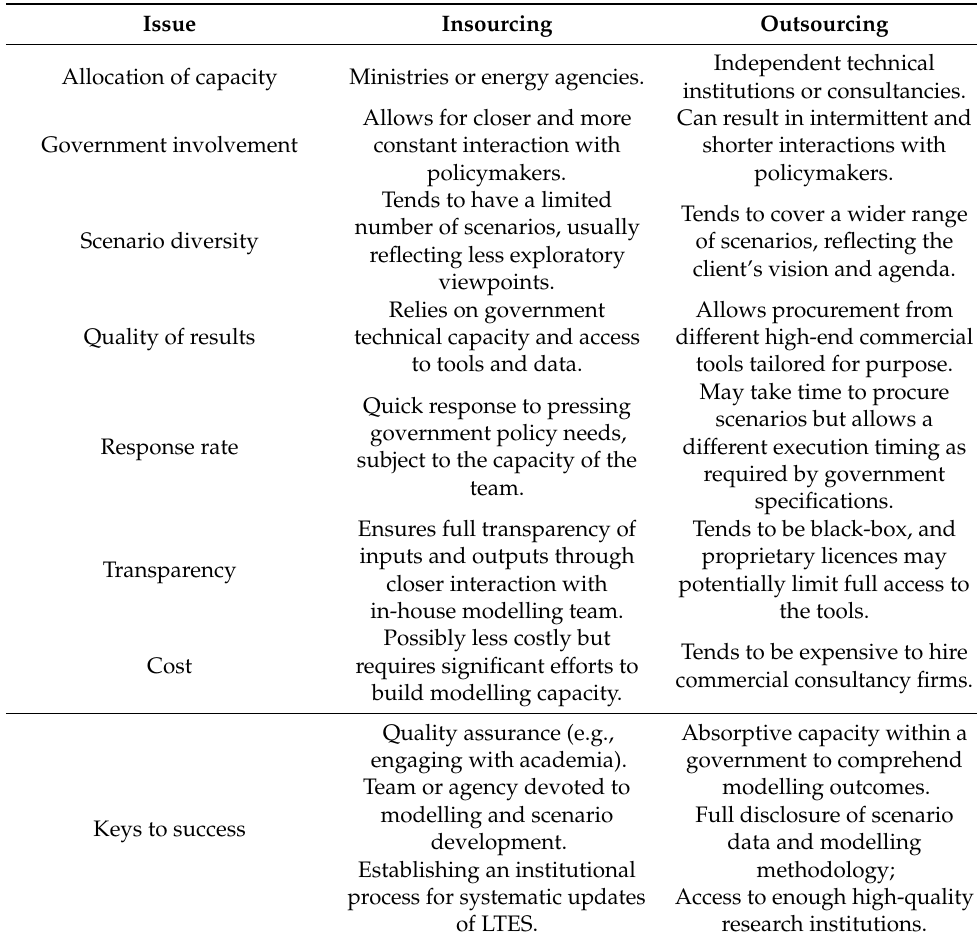
Figure 8. Allocation of LTES development capacity from the government’s perspective. Table 3. Keys for success and advantages and challenges of insourcing and outsourcing LTES development capacity from the government’s